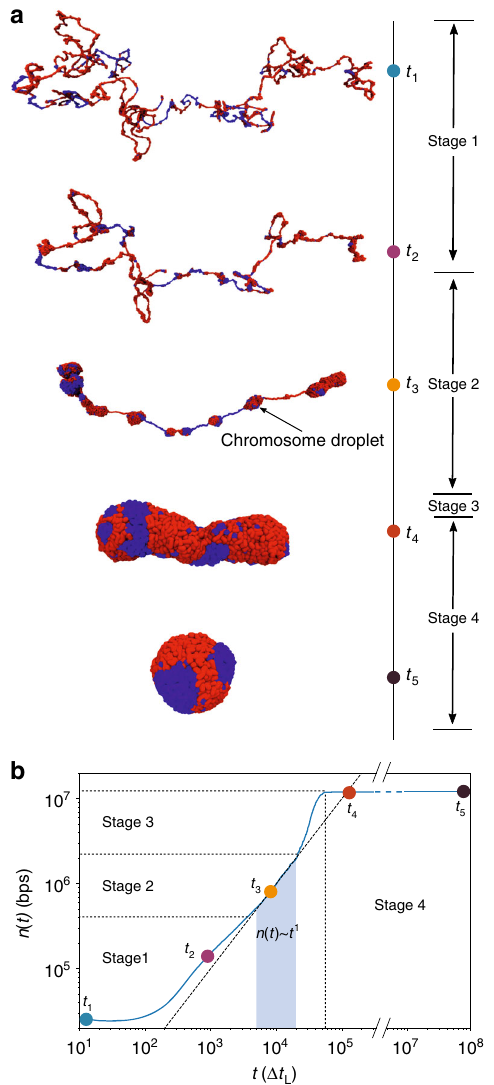
Fig. 9 Dynamics of chromosome organization. a Typical conformations sampled during the chromosome organization process. After the short initial folding process (stage 1, t 1 and t 2 ), the chromosome droplets (CDs) connected by “ tension strings ” begin to form (stage 2, t 3 ). The average size of CDs at the onset of CD formation is about s ~ 4 × 10 5 bps, which coincides with approximate value of s *, the typical size of TADs (Fig. 1b). At the later stage (stage 3, conformation not shown here), CDs merge to form larger cluster, eventually form the fi nal condensed structure (stage 4, t 4 and t 5 ). Red (blue) represents repressive (active) loci. b The time-dependent growth of CDs, n ( t ), which is the average number of base pairs in a CD at t . The dashed line is a fi t in the time window indicated by the shaded area, yielding n ( t ) ~ t 1 . The roughly linear increase of n ( t ), over a range of times, is consistent with the Lifshitz – Slazov growth mechanism 59 . For a P ( s ) ~ s − 0.75 scaling for s < s * (see also Fig. 1b) is the result of organization on the small genomic scale during the early stage of chromosome condensation (Fig. 9a). In the initial stages, com- paction starts by forming ≈ s * sized chromosome droplets (CDs) as illustrated in Fig. 9a. In the second scaling regime, P ( s ) ~ s − 1.25 , global organization occurs by coalescence of the CDs (Fig. 9a). Thus, our CCM model, which suggests a hierarchical chromo- some organization on two distinct scales, also explains the two scaling in P ( s ).